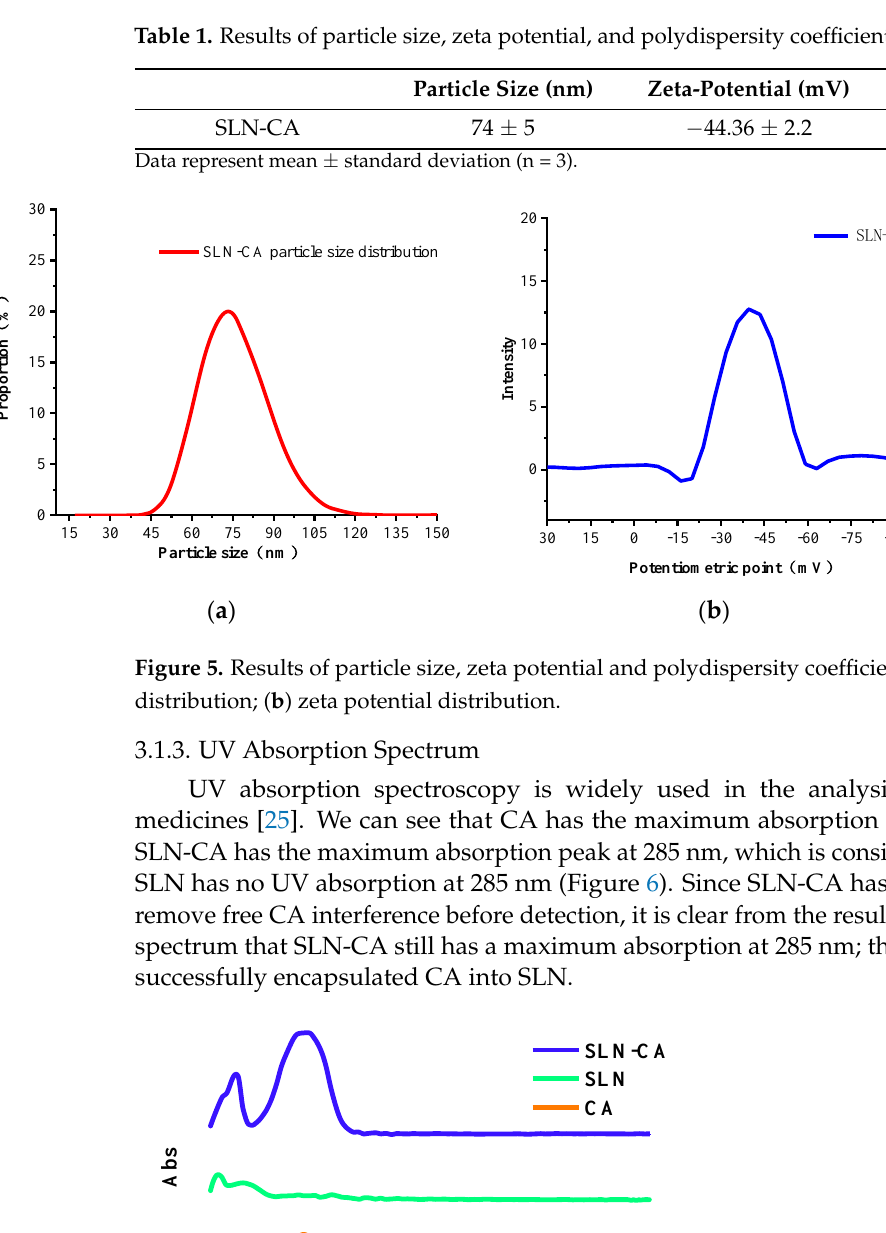
Figure 7. CA absorbance at 220 nm vs. concentration standard curve. 3.1.5. FT-IR The FT-IR results show that the CA patterns at 2861 cm −1 and 2742 cm −1 are generated by the C-H stretching vibration of the aldehyde group, and the C=O has a stretching vi- bration at 1678 cm −1 (Figure 8). The physical mixture profile appears to be a superposition of the two, showing the characteristic absorption peak of CA and the characteristic ab- sorption of SLN. It is proven that in the physical mixture, there is no interaction between the components of CA and SLN, but simply mixing [26]. In the spectrum of SLN-CA, the C-H of the aldehyde group of CA 2861 cm −1 and 2742 cm −1 disappeared, and the peaks at 3100 – 3500 cm −1 became broad and significant, indicating some binding interaction be- tween CA and the nanoparticles. On the other hand, there are no new absorption peaks in the whole spectrum (Figure 8) [14].